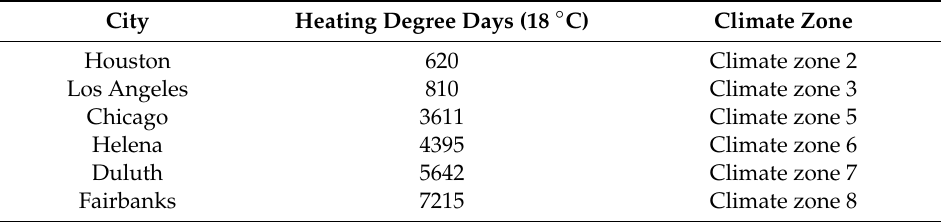
Table 8. Typical cities selected according to American climate zones.